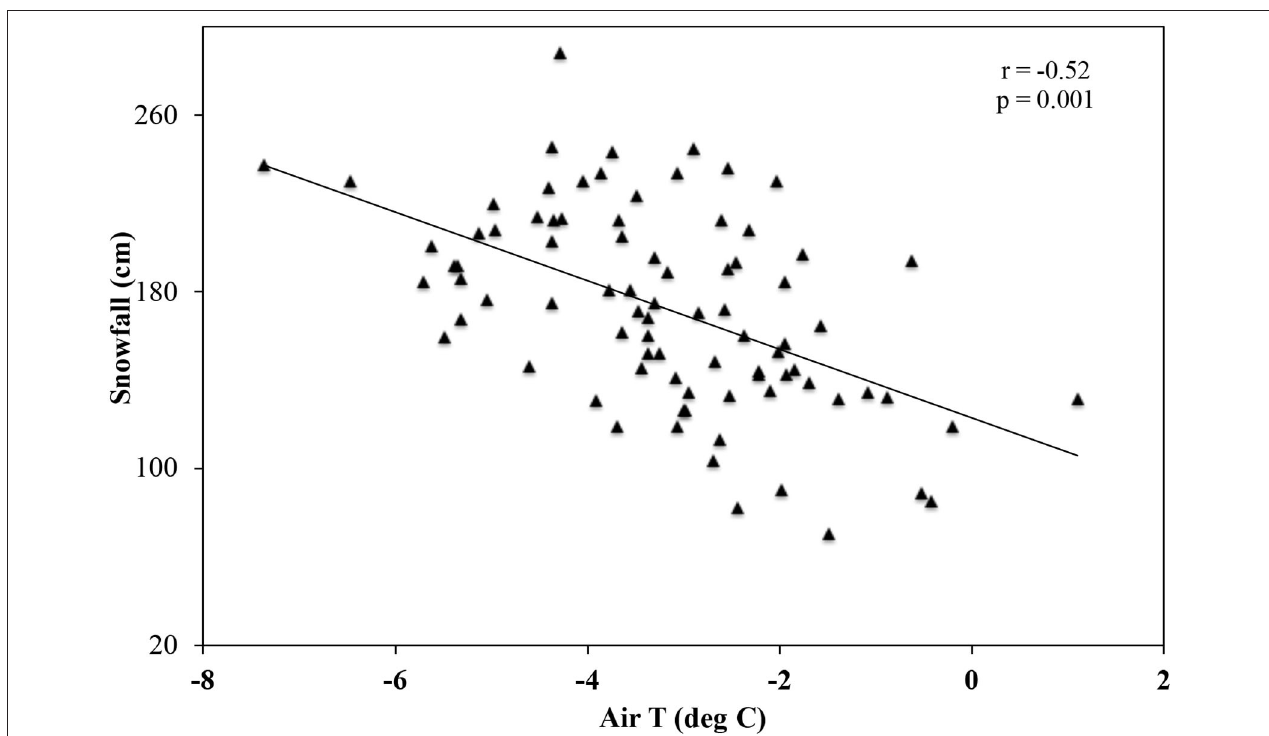
FIGURE 4 | Scatter plot of average annual total snowfall over the eight stations vs. regional average air temperatures. A Pearson correlation coefficient ( r ) and p -value are shown on the figure.